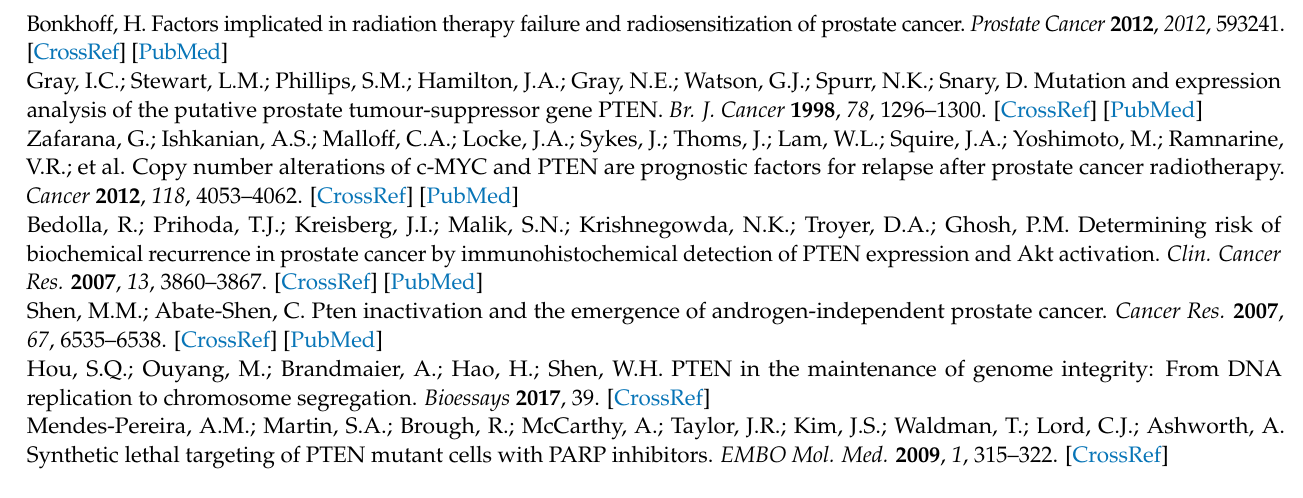
treatment. Figure S4: (A) Levels of DNA damage in HCT-116 WT and KO22 cells following KU-60019 and IR alone or in combination. Mean γ -H2AX foci per cell was plotted at 1, 4 and 24 h post-treatment with 1 Gy IR or 1 Gy + 1 µ M KU-60019. Differences between two groups were compared by using a two-sample student’s t -test (one asterisk (*), p < 0.05; two asterisks (**), p < 0.01). (B) Mean Rad51 foci per cell in HCT-116 WT and KO22 cells basally and 1 h following 2 Gy ionising radiation. Differences between two groups were compared by using a two-sample student’s t -test. NS denotes a non- significant difference. (C) Western blot analysis showing basal expression of total Rad51 in HCT-116 WT and KO22 cell models. Figure S5: Immunofluorescence images of (A) PC-3 and (B) HCT-116 isogenic models showing staining of phosphorylated histone H2AX foci ( γ -H2AX) (Green) and 4,6- diamidino-2-phenylindole (DAPI) (Blue). Images were taken of cells at 1, 4 and 24 h post-treatment with 1 µ M KU-60019 and 1 Gy IR alone or in combination. Figure S6: Box plot of mean relative change in animal body weight following treatments with KU-60019, Ionising radiation and combination treatments. Figure S7 Uncropped Western Blots from Figure